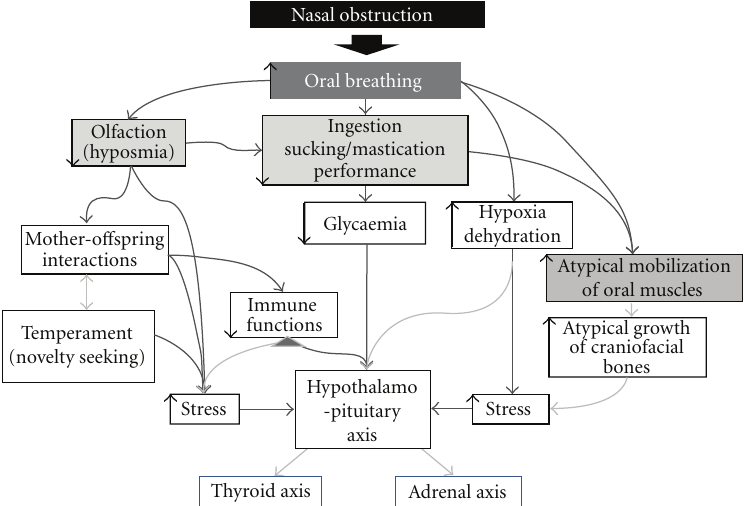
Figure 2: Representation of the main structures and processes involved in an episode of nasal obstruction in the neonate rat model. there are functional limits and ceiling e ff ects that need to be better understood in human